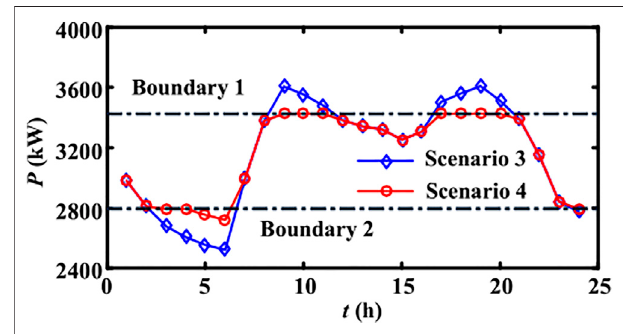
FIGURE 16 | Voltage curves under different scenarios at 19:00.